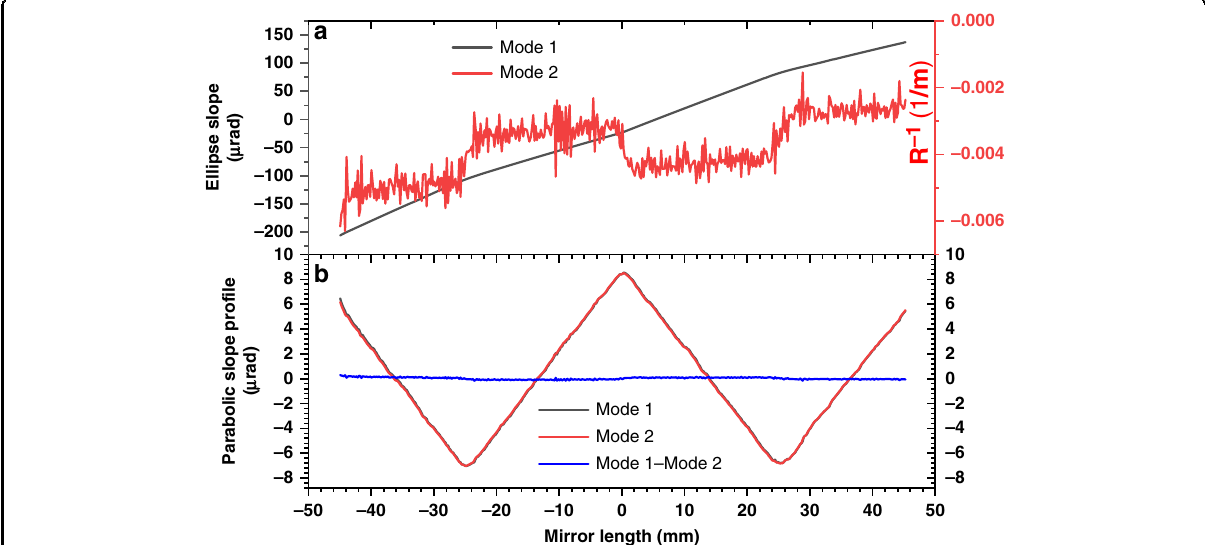
Fig. 4 Examples for comparison between 2 data processing modes. a The measured tangential slope and reciprocal local radius of curvature with Mode 1 and Mode 2, respectively, of the elliptical mirror with superimposed parabolic arcs. b The retrieved slope pro fi le after subtraction of the best- fi t ellipse as measured by Mode 1 and Mode 2, and the difference between